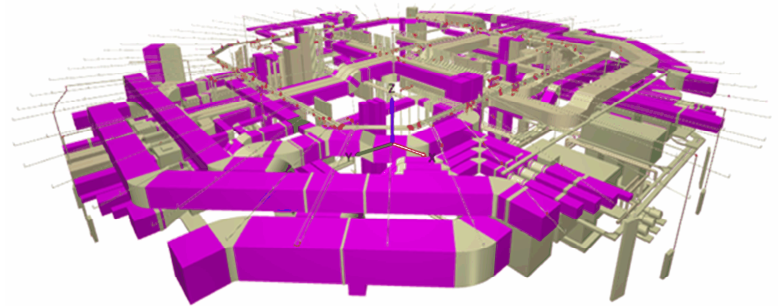
Figure 12. The MEP model for the 5th floor of the Chinese resource headquarters building.